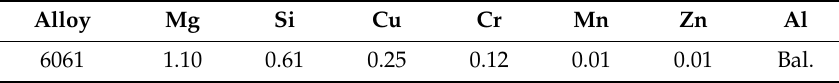
Table 1. Chemical composition of 6061 aluminum alloy (wt.%).